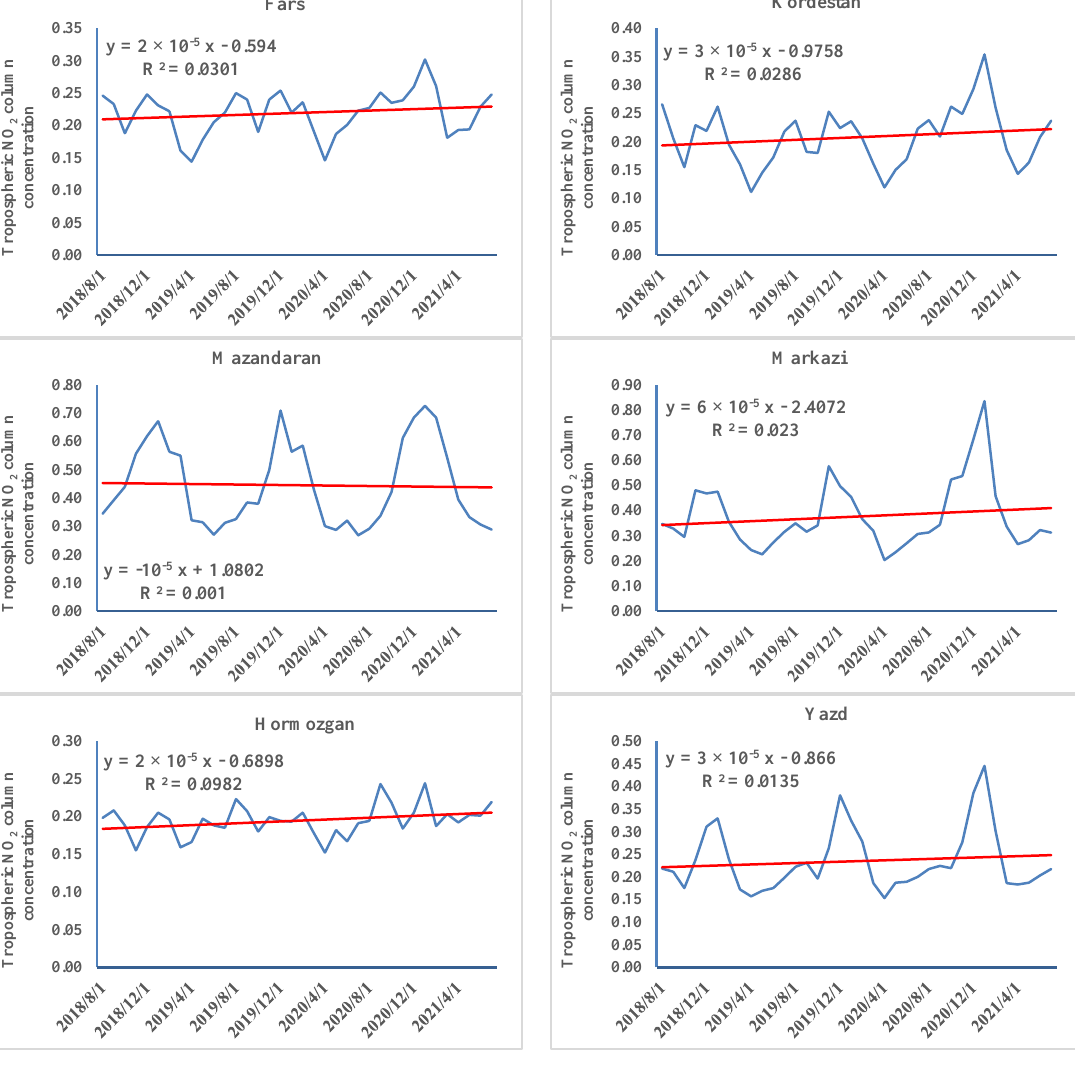
Figure 7. Monthly fluctuation of tropospheric NO 2 columns (10 15 molecules cm −2 ) in some industrial and densely populated provinces (Tehran and Isfahan) and some non-industrial and sparsely populated provinces (Sistan and Baluchestan). (Red lines in the charts are trend lines for NO 2 ). The monthly average concentration of tropospheric NO 2 column data obtained using the TROPOMI sensor was extracted for each county. The NO 2 map was classified into five classes: very low, low, medium, high, and very high. Finally, the area and population of each class were extracted, and the results are listed in Table 4. As can be seen from the results, less than 0.5% of the area of cities are in the severe and very severe classes of tropospheric NO 2 column, and 15% of the total population of Iran (more than 13 million people) live in this area. This shows the importance of population density in increasing air pollution. In addition, Table 4 shows about 73% of the population of Iran lives in the low and very low air pollution classes.